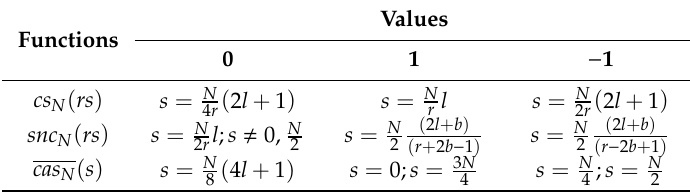
Table 1. Special values of the discrete sinusoidal functions.